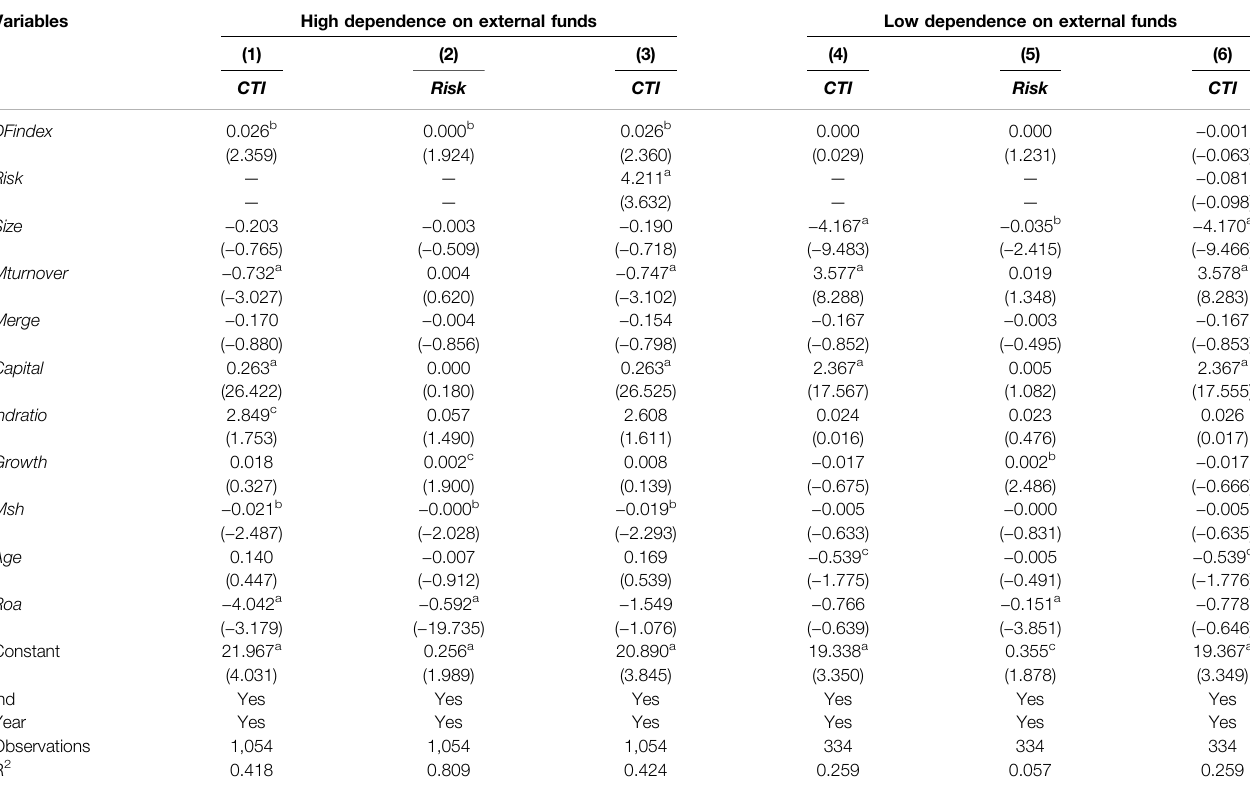
TABLE 8 | Heterogeneity analysis results based on external capital